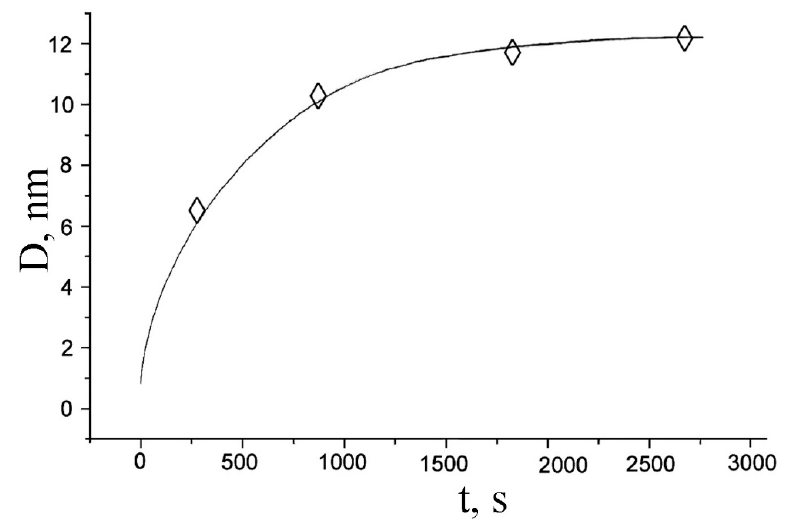
Figure 9. Dependence of an average size of the nanocrystals in Al86Ni11Yb3 alloy on the exposure duration at 473 K. The calculated results are marked with a solid line, the experimental values are shown with rhombi [59].